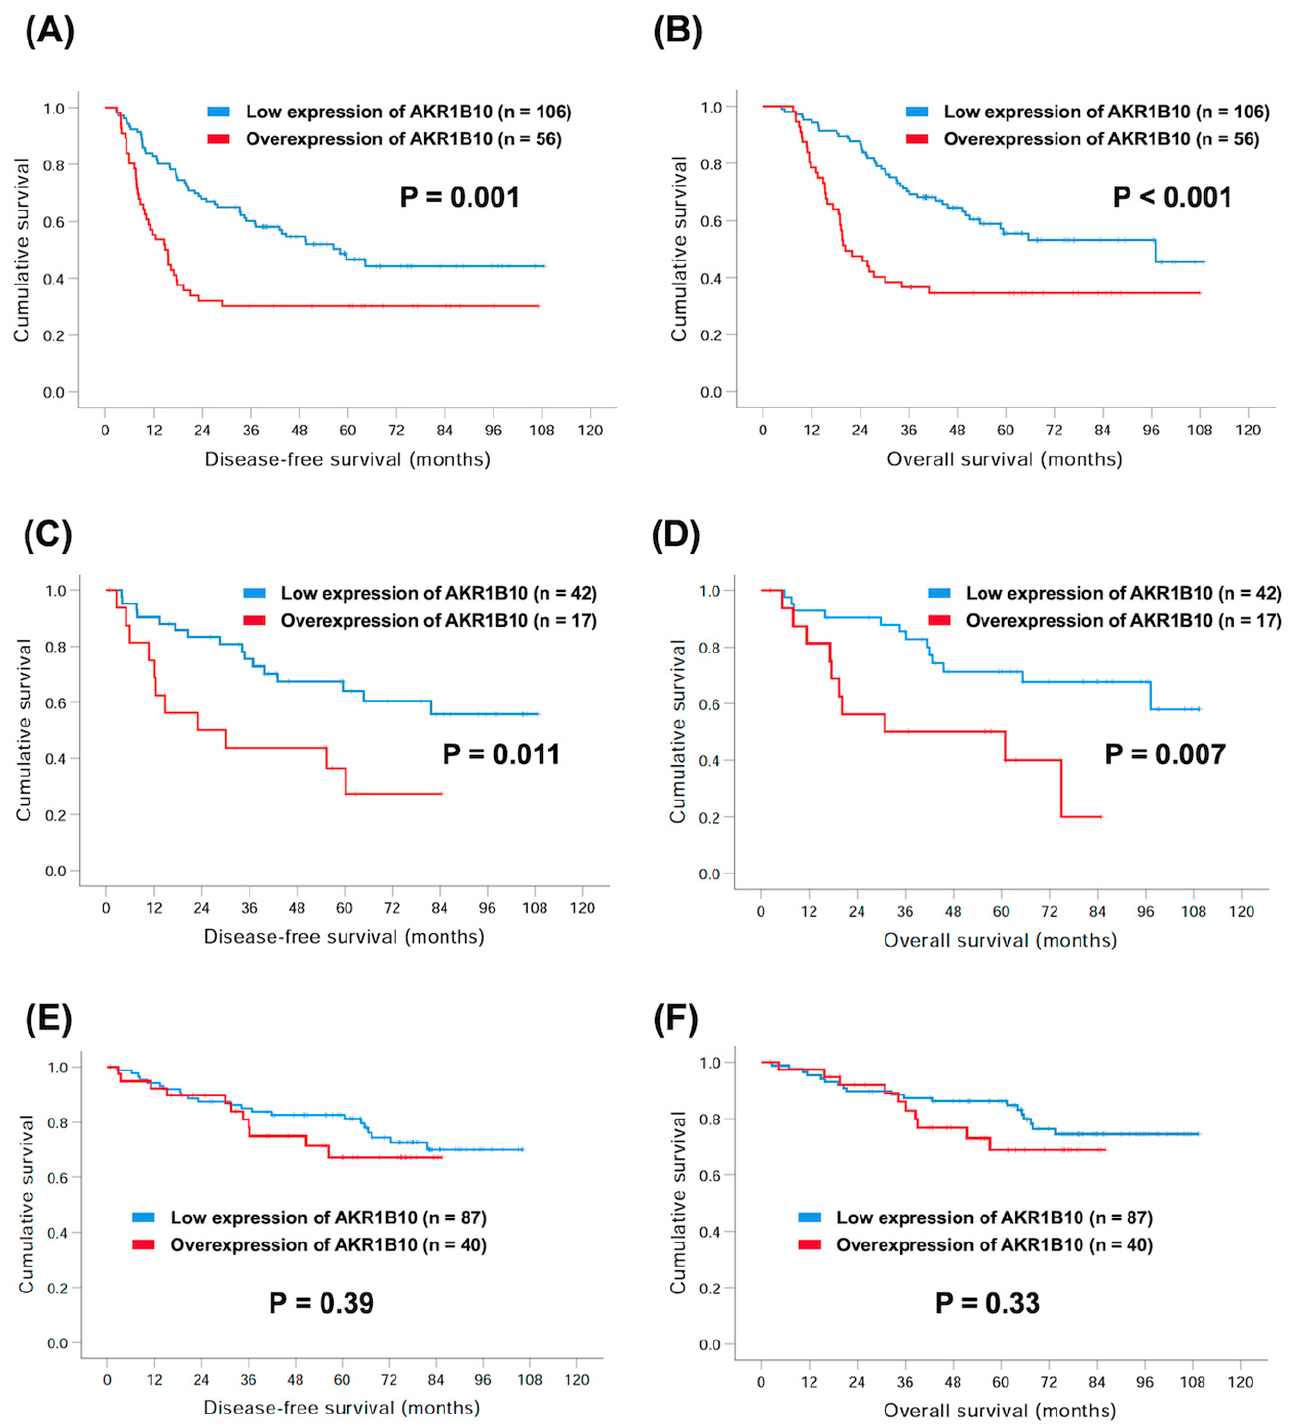
Figure 3. Comparison of Kaplan–Meier curves of 5-year DFS and OS rates between GC patients with overexpression and low expression of AKR1B10. Adjuvant chemotherapy subgroup: ( A ) DFS and ( B ) OS; signet ring cell carcinoma subgroup: ( C ) DFS and ( D ) OS; pathological stage I subgroup: ( E ) DFS and ( F ) OS.